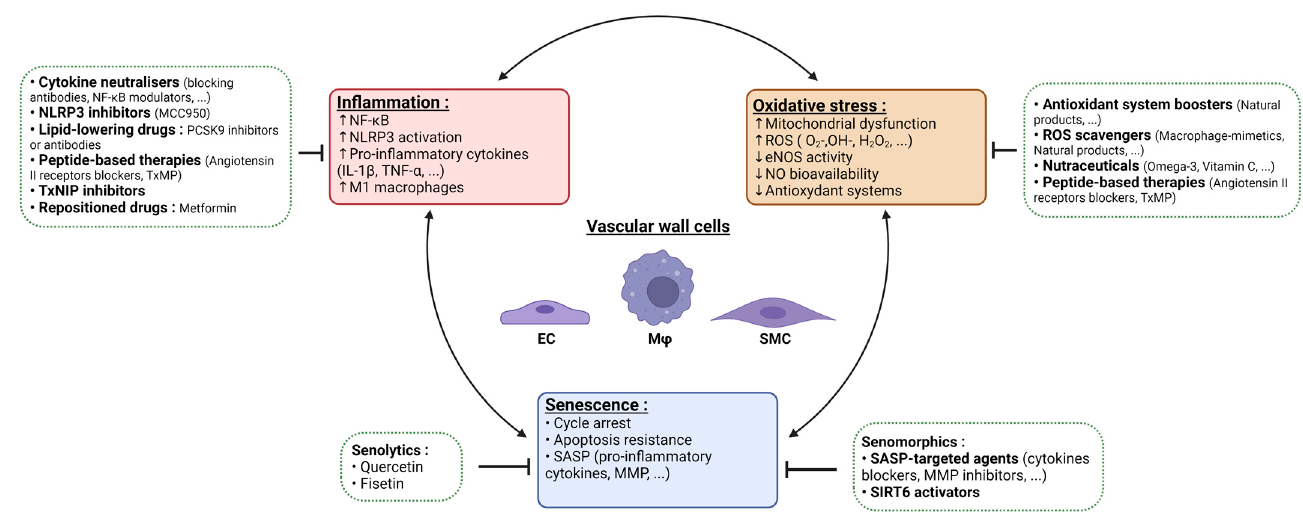
Figure 3. Atherosclerosis triad: targeting inflammatory pathways, oxidative stress, and senescence to derive innovative therapeutic strategies. In atherosclerosis, inflammation, oxidative stress and senescence are interconnected processes (arrows). In this context, main deregulated factors are given for each process together with the principal classes of therapeutic options (green dashed frames), including anti-inflammatory agents (cytokine blockers, inflammasome inhibitors, NF- κ B modulators); antioxidants (ROS scavengers, antioxidant system boosters); senolytics; and senormorphics.